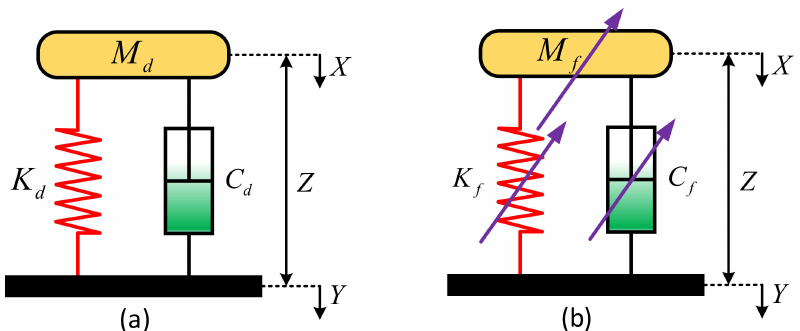
Figure 5. Schematic diagram of vibration isolation systems: ( a ) Linear vibration isolation system; ( b ) Nonlinear vibration isolation